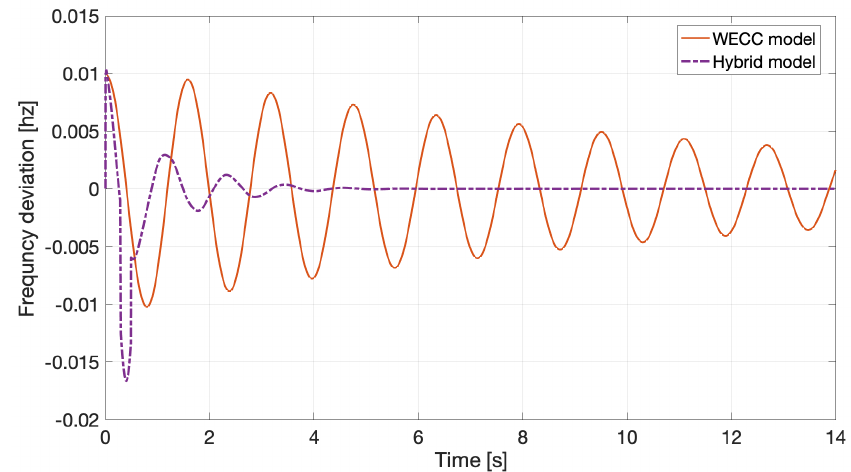
Figure 10. Third generator frequency deviation in the second area, 1.